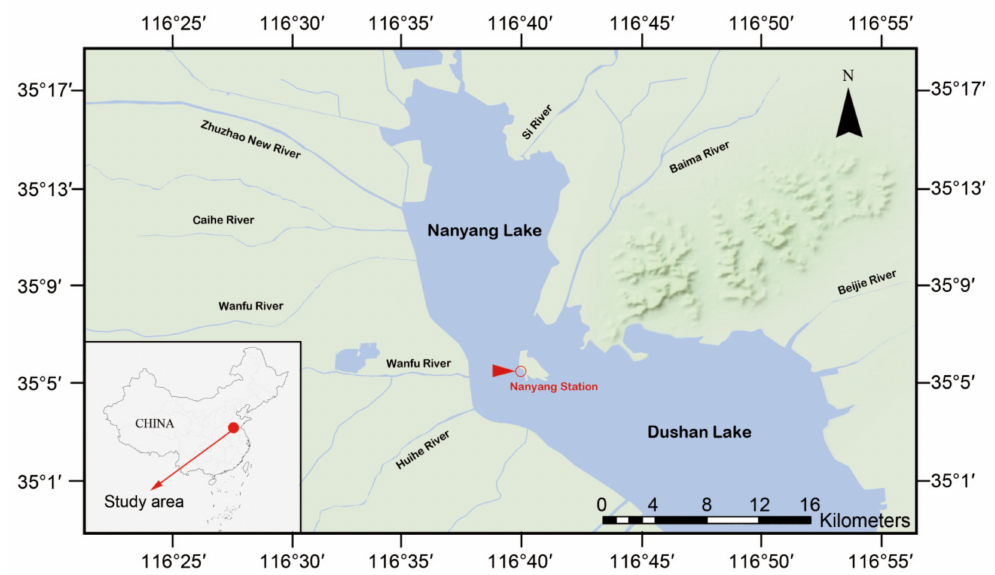
Figure 1. Map showing the location of the ponds around Nanyang